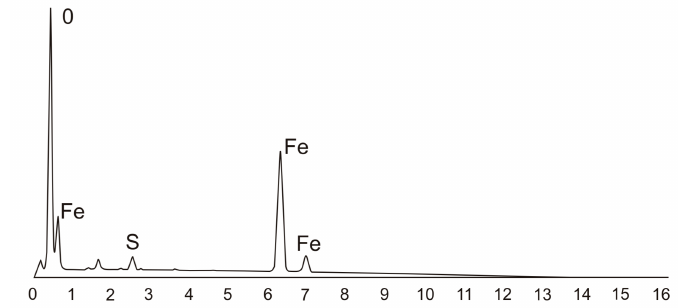
Figure 9. Results of the EDS analysis for the corroded ductile iron casting made with the in-mold method.